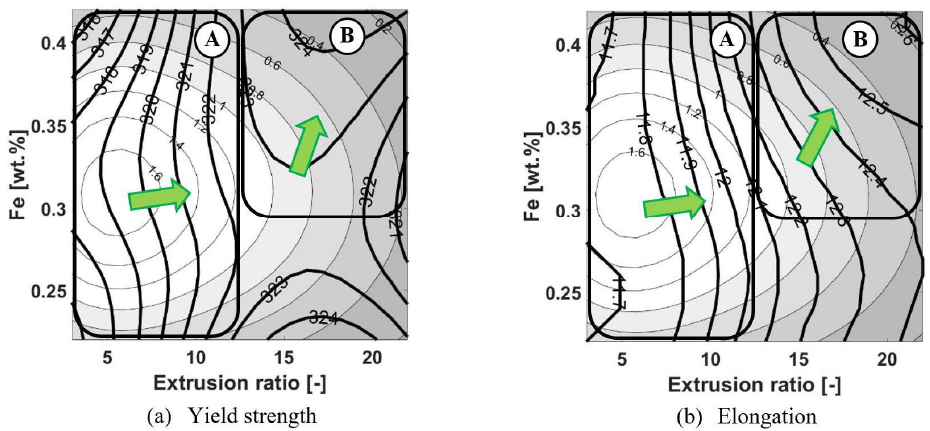
Figure 8. Common influence of extrusion ratio and Fe content on yield strength ( a ) and elongation ( b ). Green (grey) arrows indicate increase of the observed mechanical property.